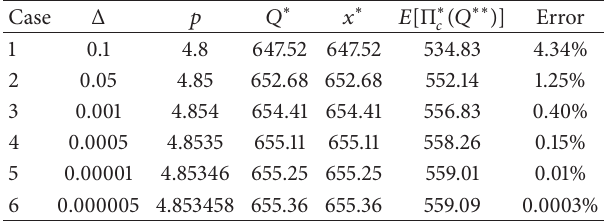
Table 2: The optimal price under different Δ .